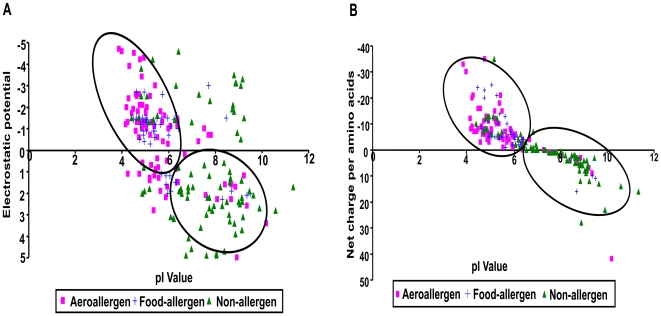
Two dimensional cluster analysis of allergens and non-allergens based on charge and pI.Square symbols denote aeroallergens, plus denotes food allergens, and inverted triangles denote non-allergens. pI is used as the X dimension in both analysis. The Y dimension is the (A) electrostatic potential score calculated from protein structure; and (B) net charge per amino acid calculated from peptide sequence.